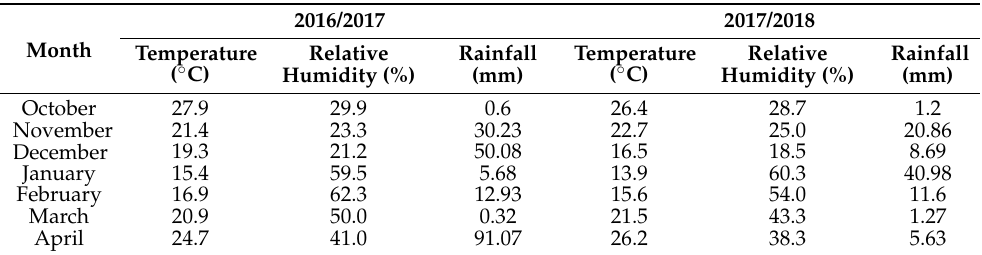
Table 1. Mean monthly climatic data at the experimental location in Wadi El-Natroon during 2016/2017 and 2017/2018 seasons *.